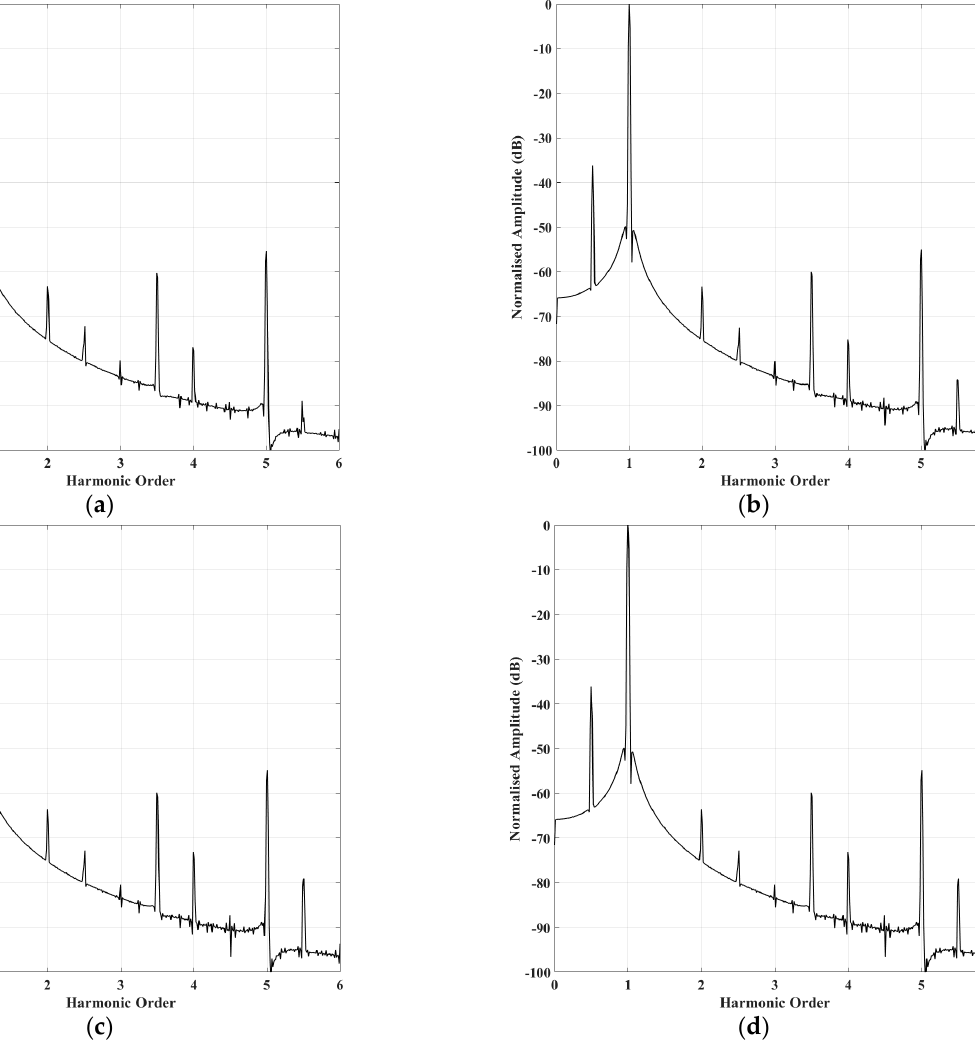
Figure A1. Simulation results. The current spectrum of the generator at 100 rpm: ( a ) Local demagnetization 5 kW; ( b ) Local demagnetization 4 kW; ( c ) Local demagnetization 2 kW; ( d ) Local demagnetization 1 kW.